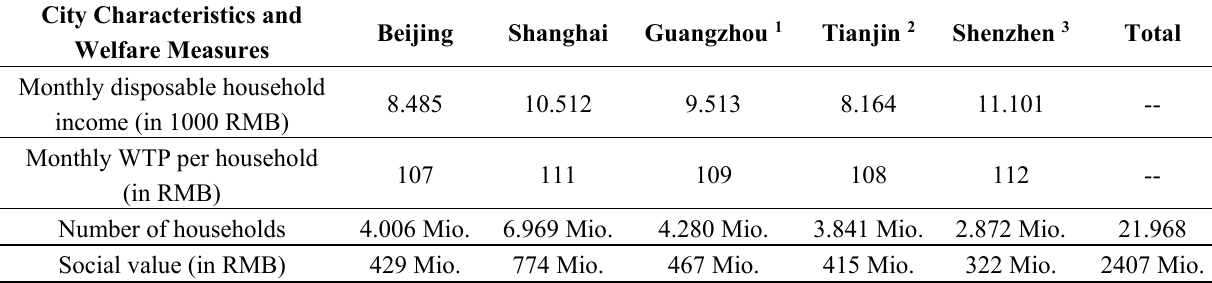
Table 6. Approximation of the overall social